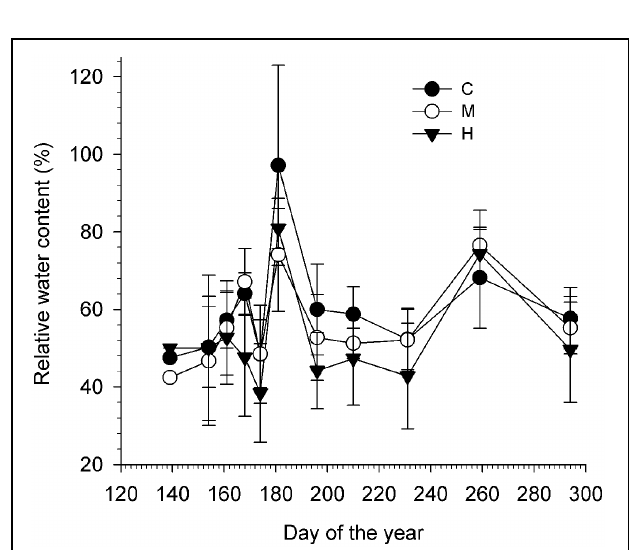
FIGURE 4 | Relative water content (RWC, %) of the twigs calculated for each defoliation class (C, control trees; M and H are moderately and heavily defoliated trees) along the growing season. Vertical bars represent the SD calculated among six